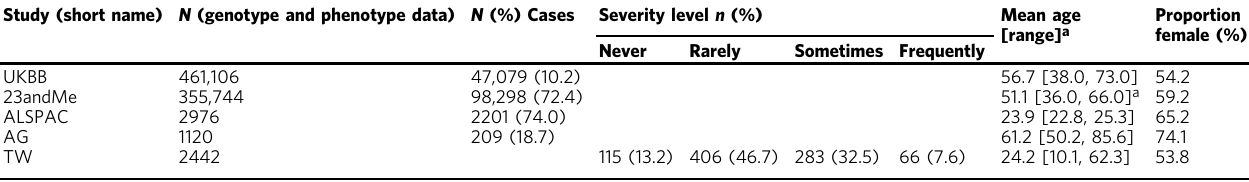
Table 1 Demographics of samples included in analysis